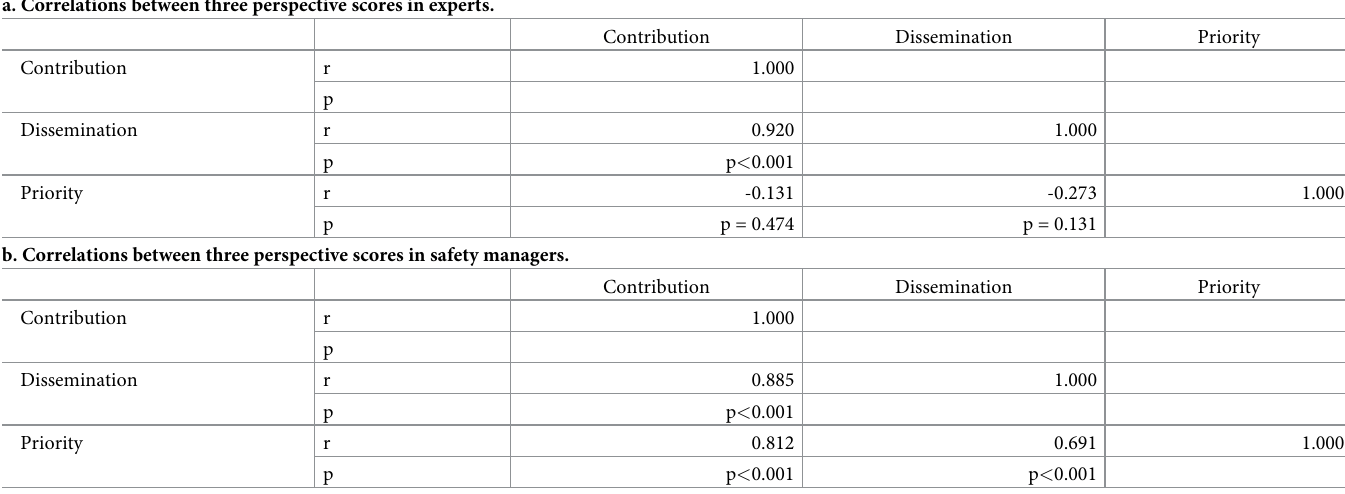
a. Correlations between three perspective scores in experts.